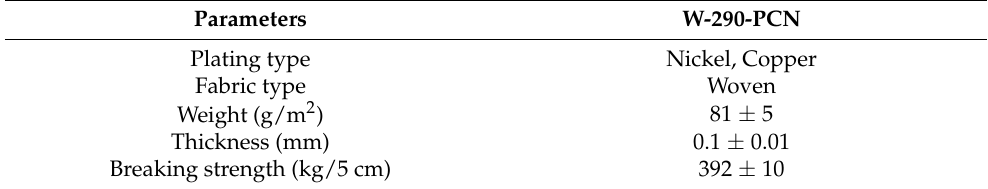
Table 1. Specifications of